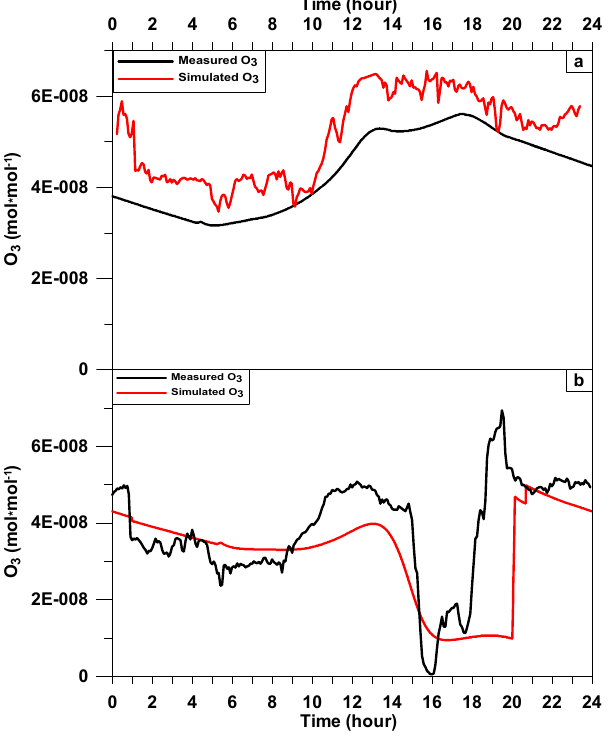
Fig. 1. Simulated and LP-DOAS measured O 3 mixing ratios. Com- Figure 1. Simulated and LP-DOAS measured O 3 mixing ratios (replace plot). parisons are shown for Julian days 201 (panel a ) and 188 (panel b ). Comparisons are shown for Julian days 201 (panel a) and 188 (panel b).